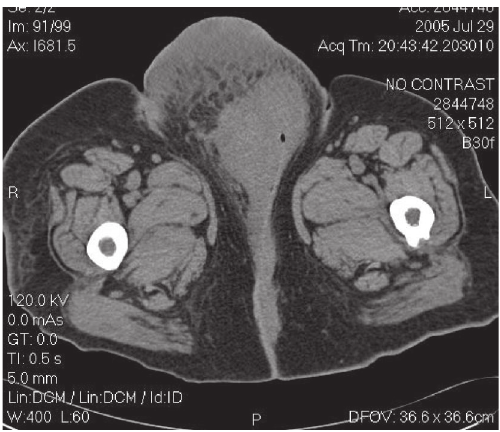
Figure 3: Pelvic CT demonstrating a 10 cm vulvar mass with solid and cystic components, without associated